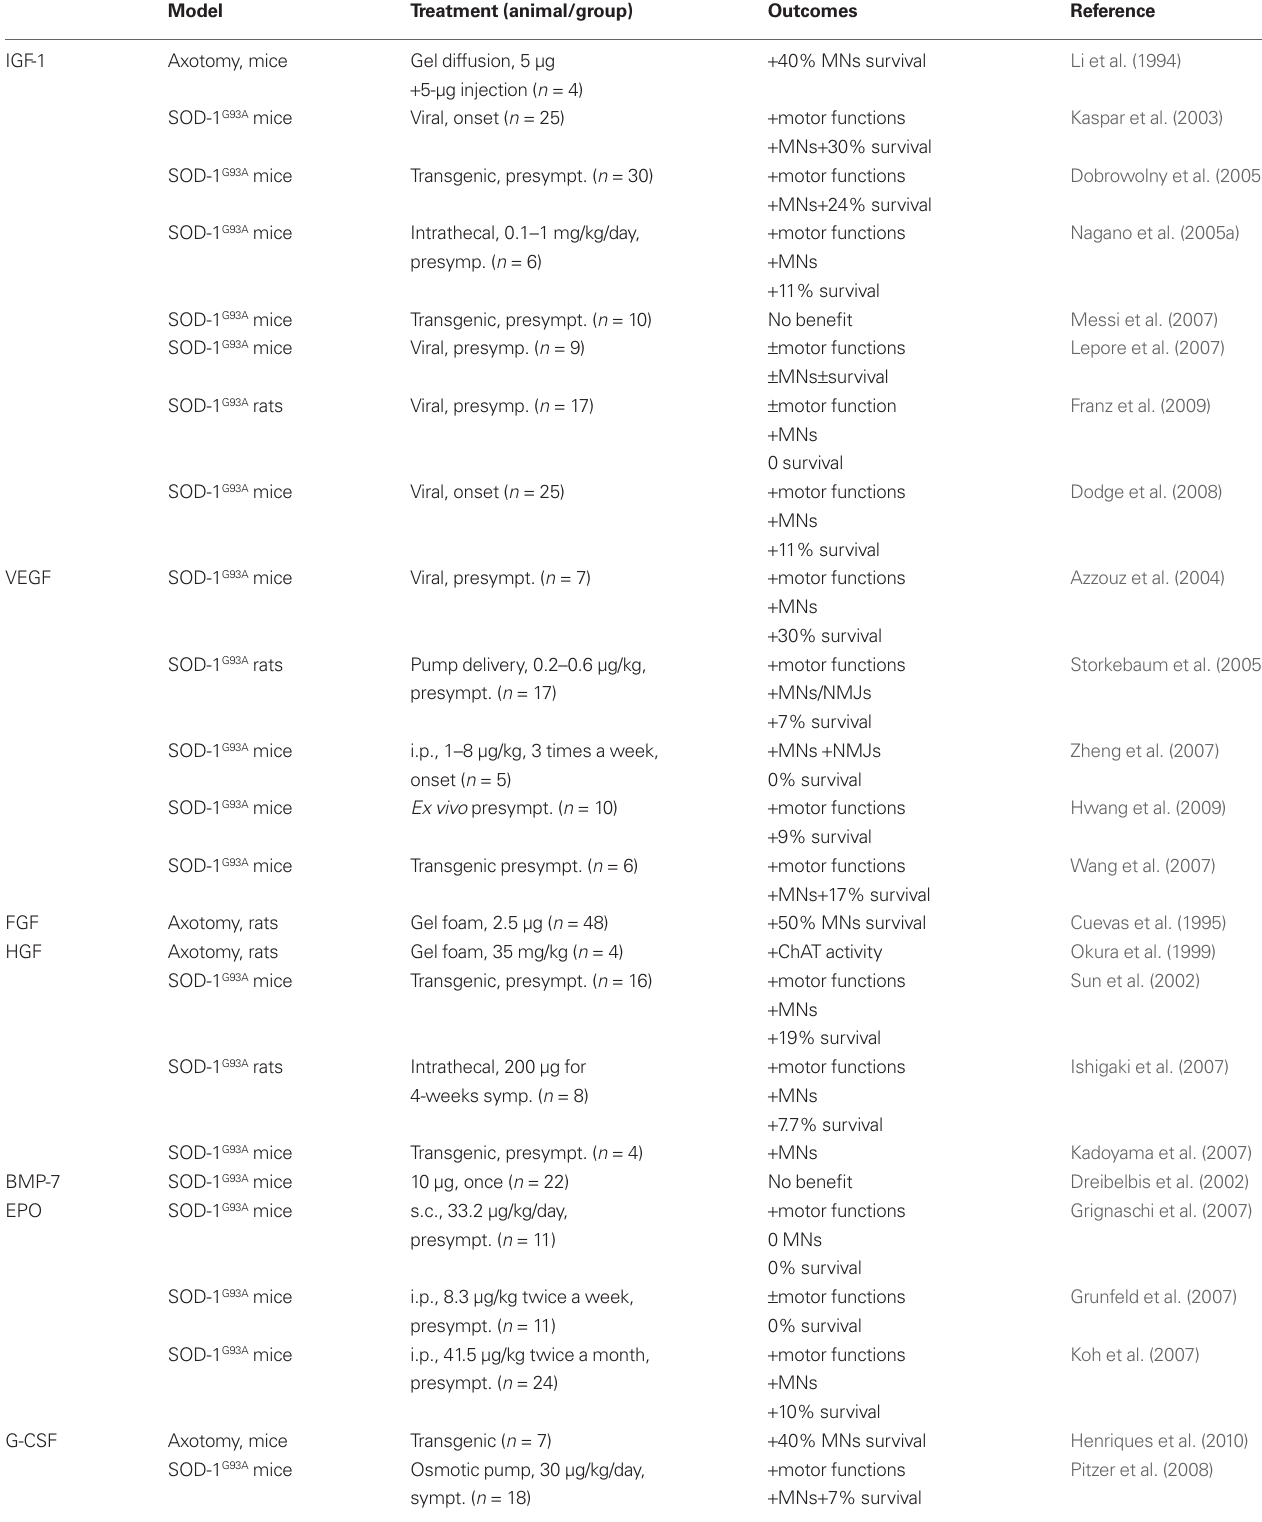
Table 2 | Listed are all non-classical neurotrophic factors that have been evaluated in animal models related to ALS. Given are the respective animal model, the application mode of the factor, and the outcome of the